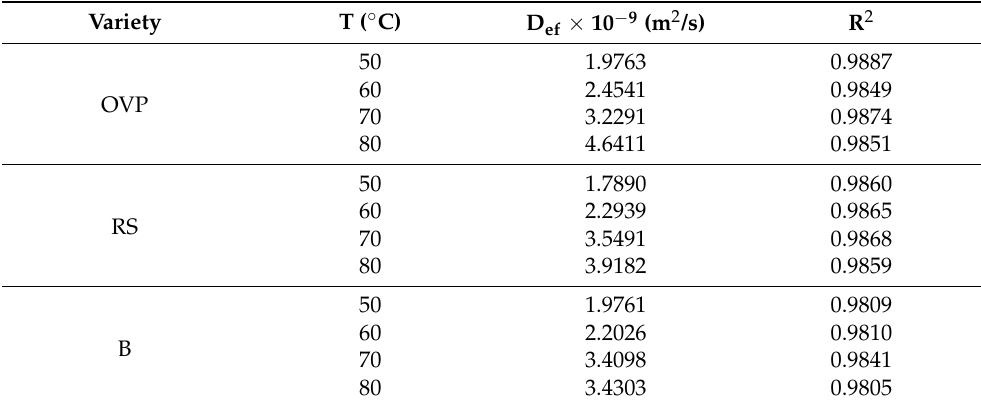
Table 4. Effective diffusion coefficients obtained from drying germinated seeds of faba beans at temperatures of 50, 60, 70 and 80 °C.